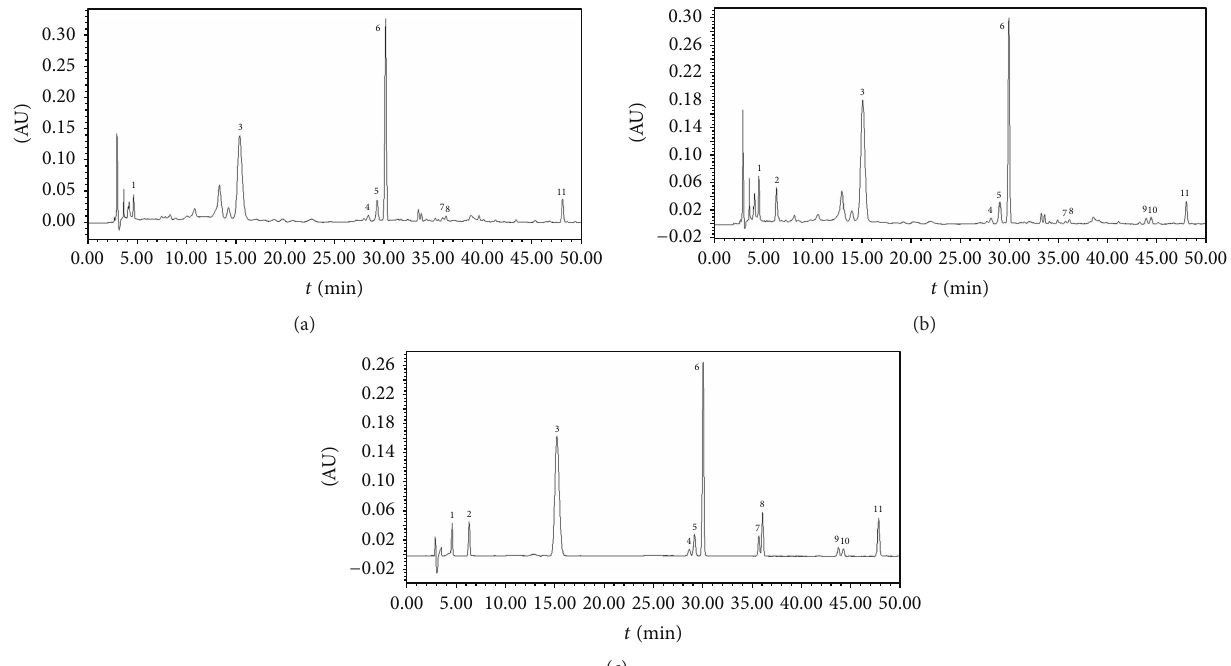
Figure 1: A chromatogram of crude Fructus Corni (a) and processed Fructus Corni (b); a chromatogram of mixture of standard compounds (c). 1: gallic acid, 2: 5-hydroxymethyl-2-furfural, 3: morroniside, 4: cornin, 5: sweroside, 6: loganin, 7: 7 𝛼 -O-methylmorroniside, 8: 7 𝛽 -O- methylmorroniside, 9: 7 𝛼 -O-ethylmorroniside, 10: 7 𝛽 -O-ethylmorroniside, and 11: cornuside.